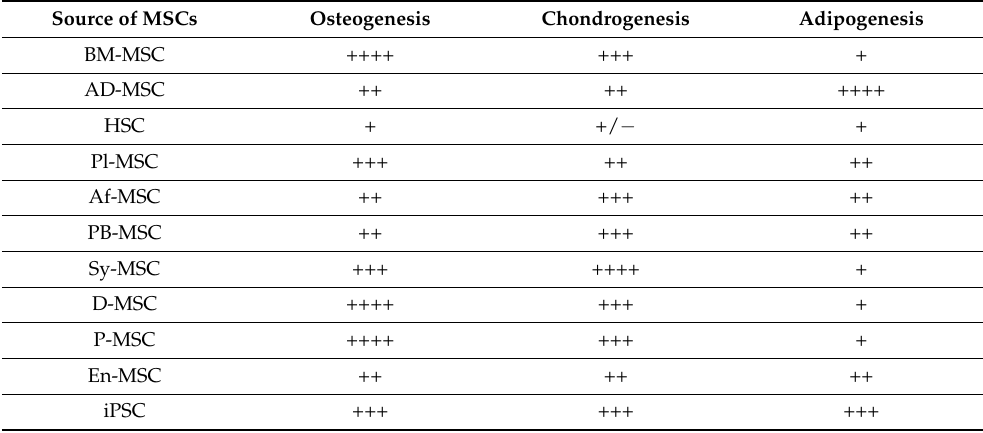
Table 1. Comparison of lineage differentiations of various sources of